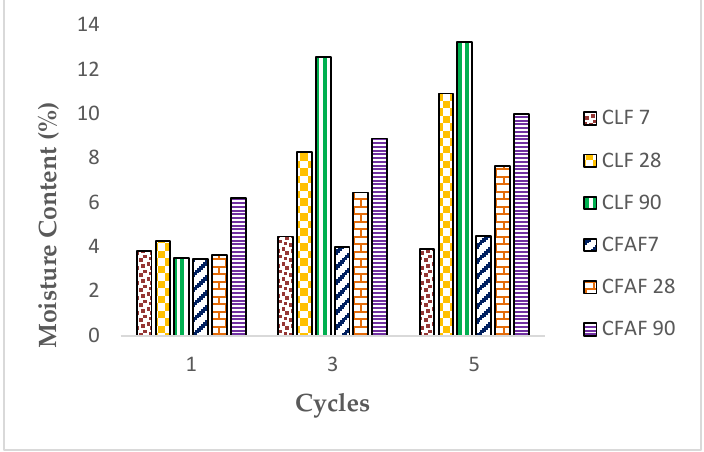
Figure 7. Moisture content versus wetting/drying cycles.